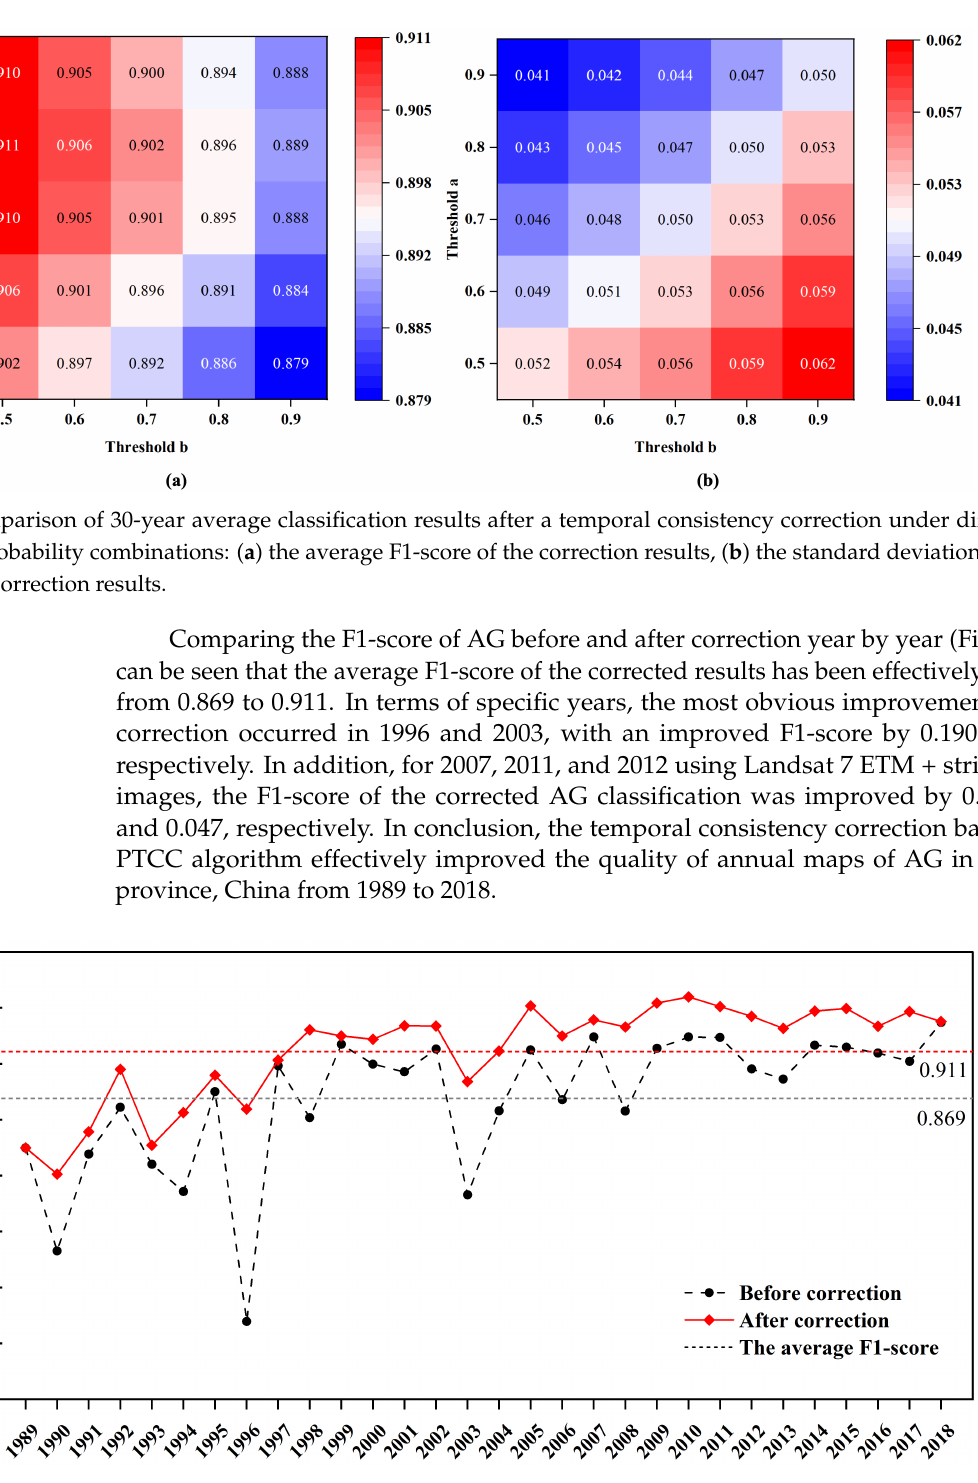
Figure 13. Comparison of F1-score of AG before and after temporal consistency correction year by